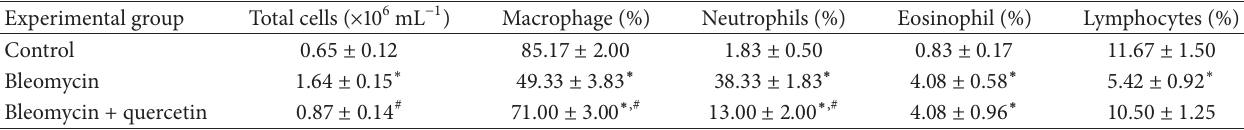
Table 2: Total leukocyte count and percentage leukocyte subset in the bronchoalveolar lavage fluid of rats from control and treatment groups.